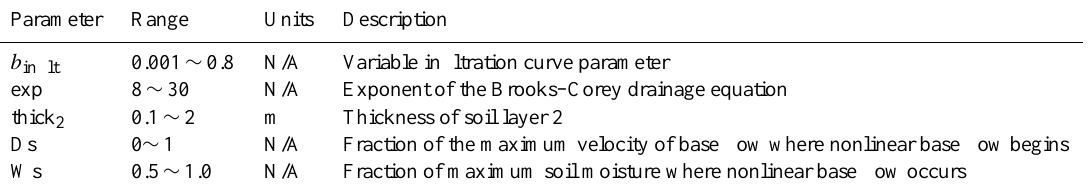
Table 1. Selected VIC parameters for